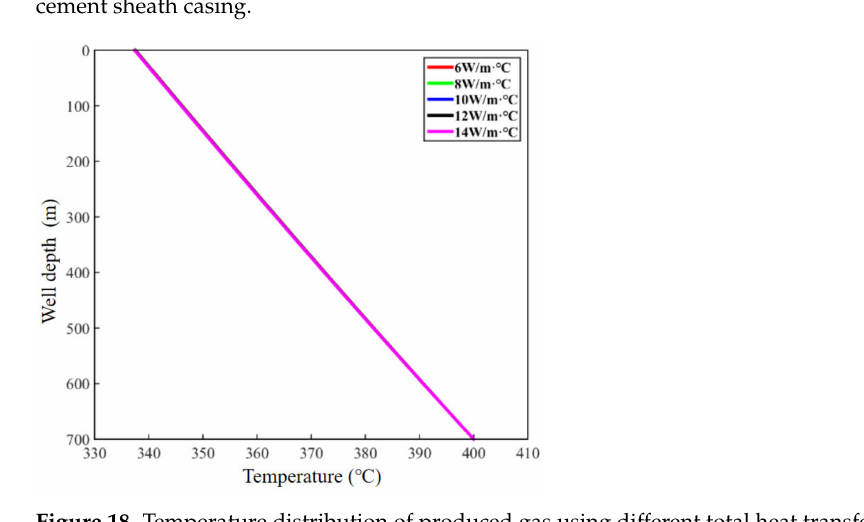
Figure 18. Temperature distribution of produced gas using different total heat transfer coefficients of cement sheath